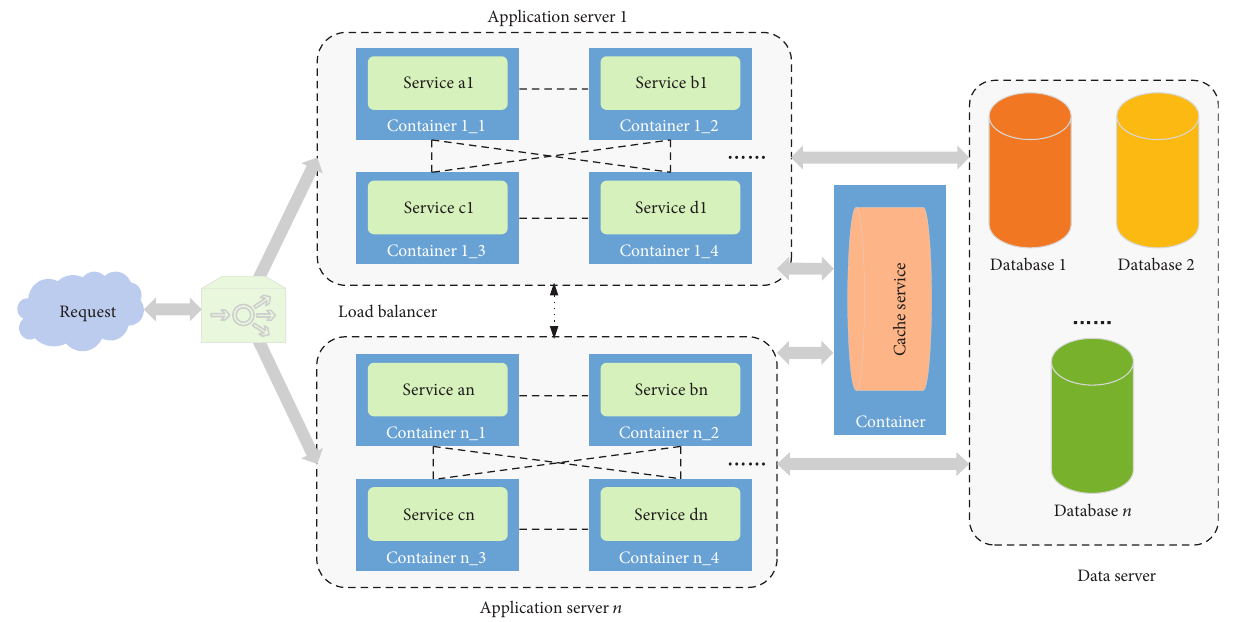
Figure 4: Service deployment. Each container is an isolated environment. Di ff erent services are deployed separately and communicate with each other to complete complex